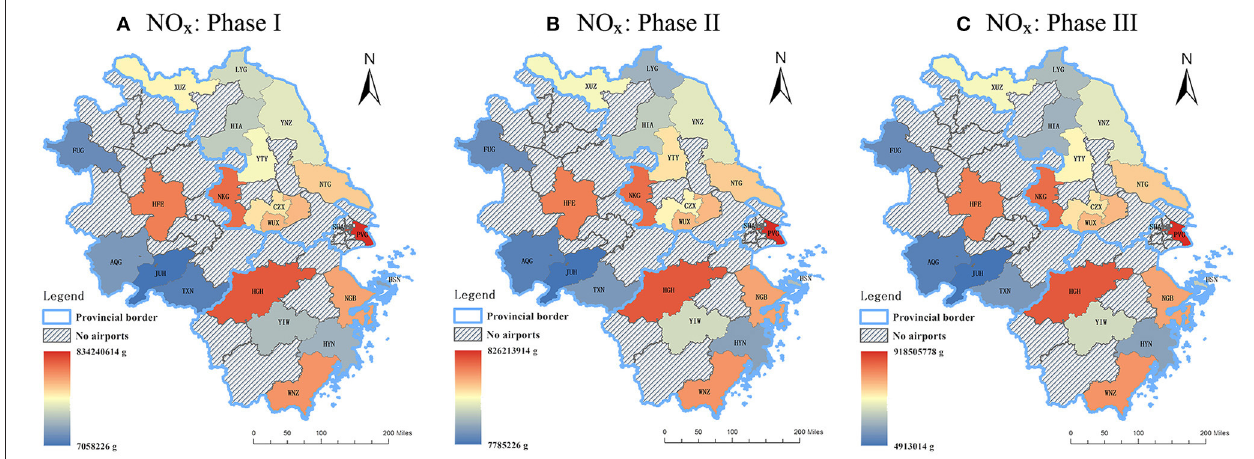
FIGURE 10 | The emission quantity of NO x during the three phases of 2020. (A) Phase I: from the beginning of January to the end of April (B) Phase II: from the beginning of May to the end of August (C) Phase III: from the beginning of September to the end of